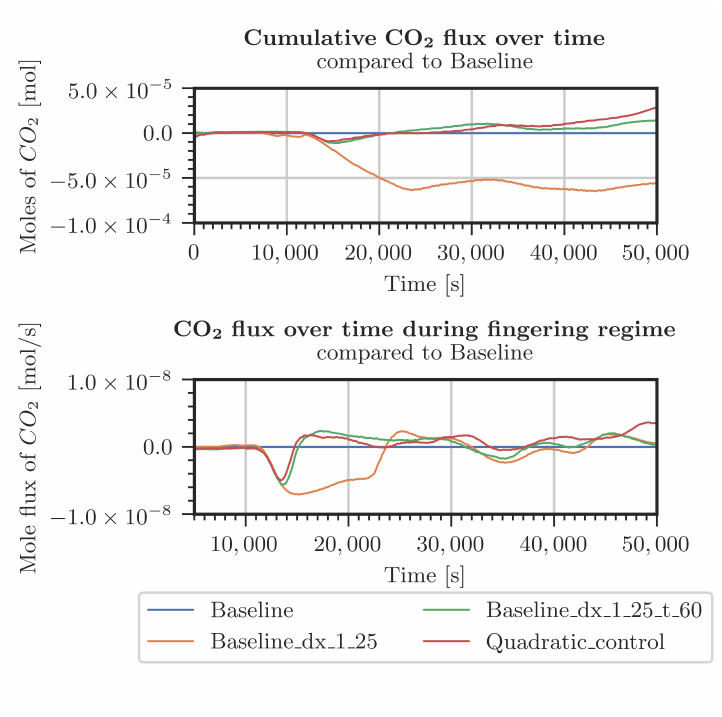
Figure A3. Difference in CO 2 entering the system for various grids (Table A1) with respect to the baseline grid. Constant pressure and CO 2 concentration at the top boundary.